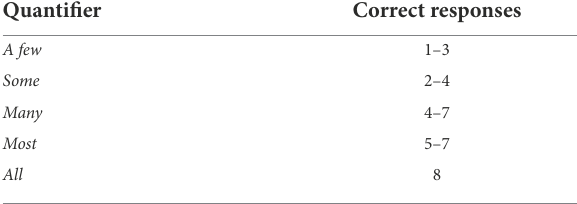
TABLE 3 Definitions of “correct” (adult-like) responses for each quantifier.